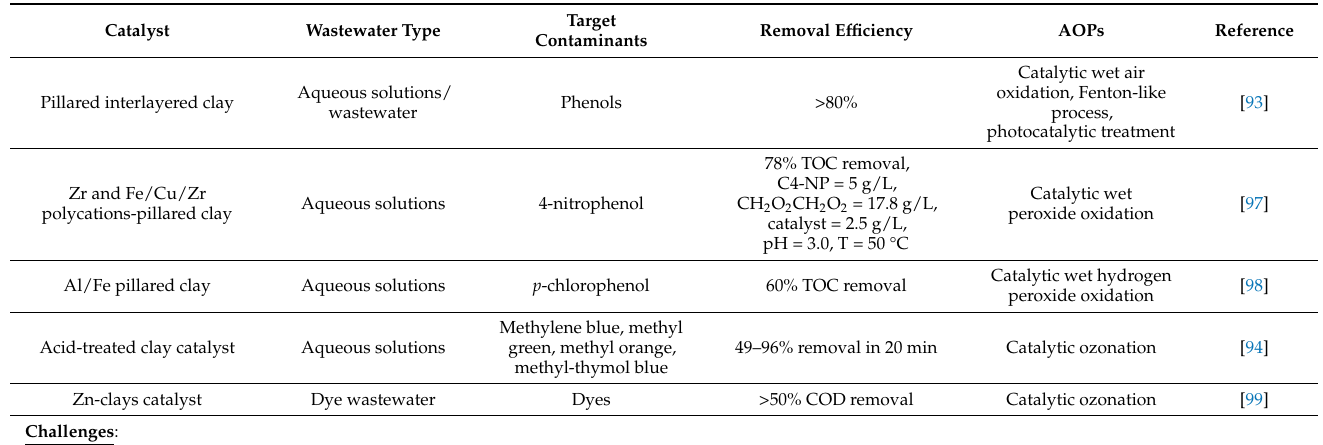
Table 9. Application of clays as nanocatalysts in AOPs for wastewater